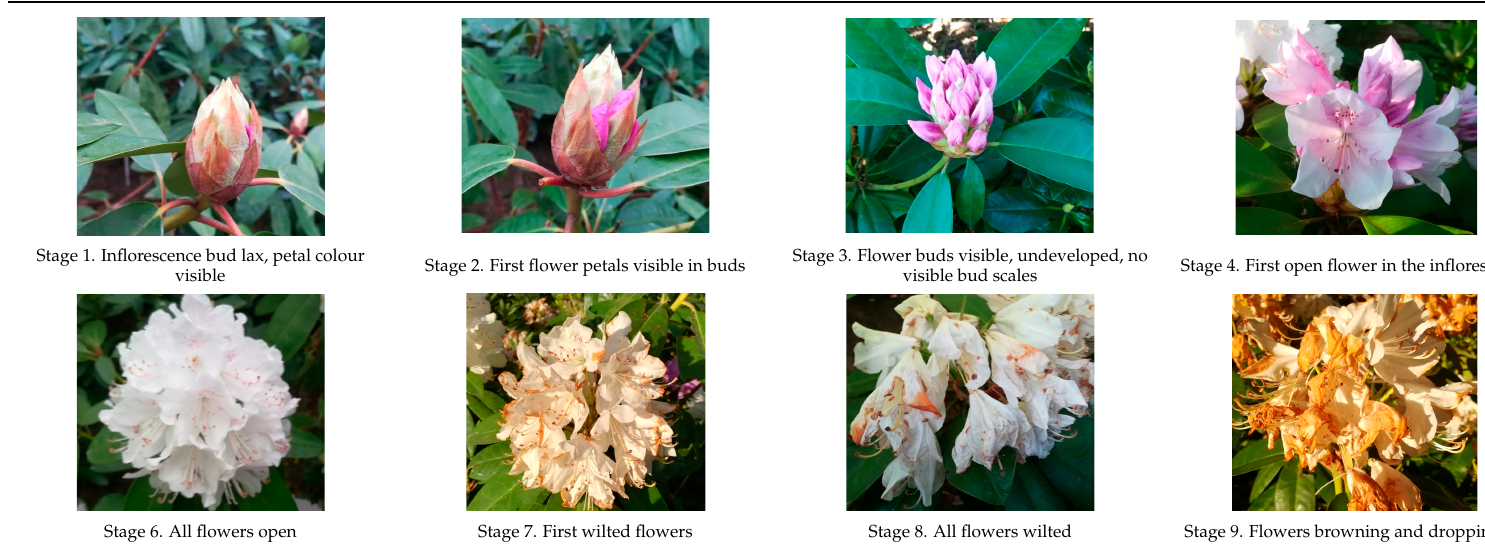
Table 2. Flower development scale used in the work.